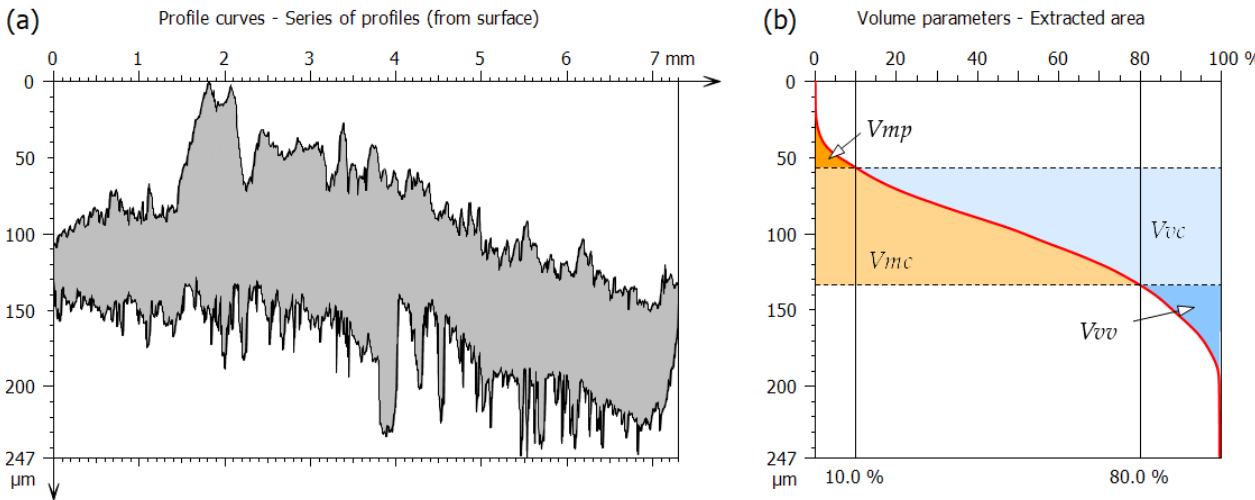
Figure 4. Graphical presentation of the functional (volume) parameters, for 10HNAP ( r = 0) specimen: ( a ) series of surface profiles; ( b ) functional (volume) parameters of Abbott-Firestone curve according to ISO 25178.